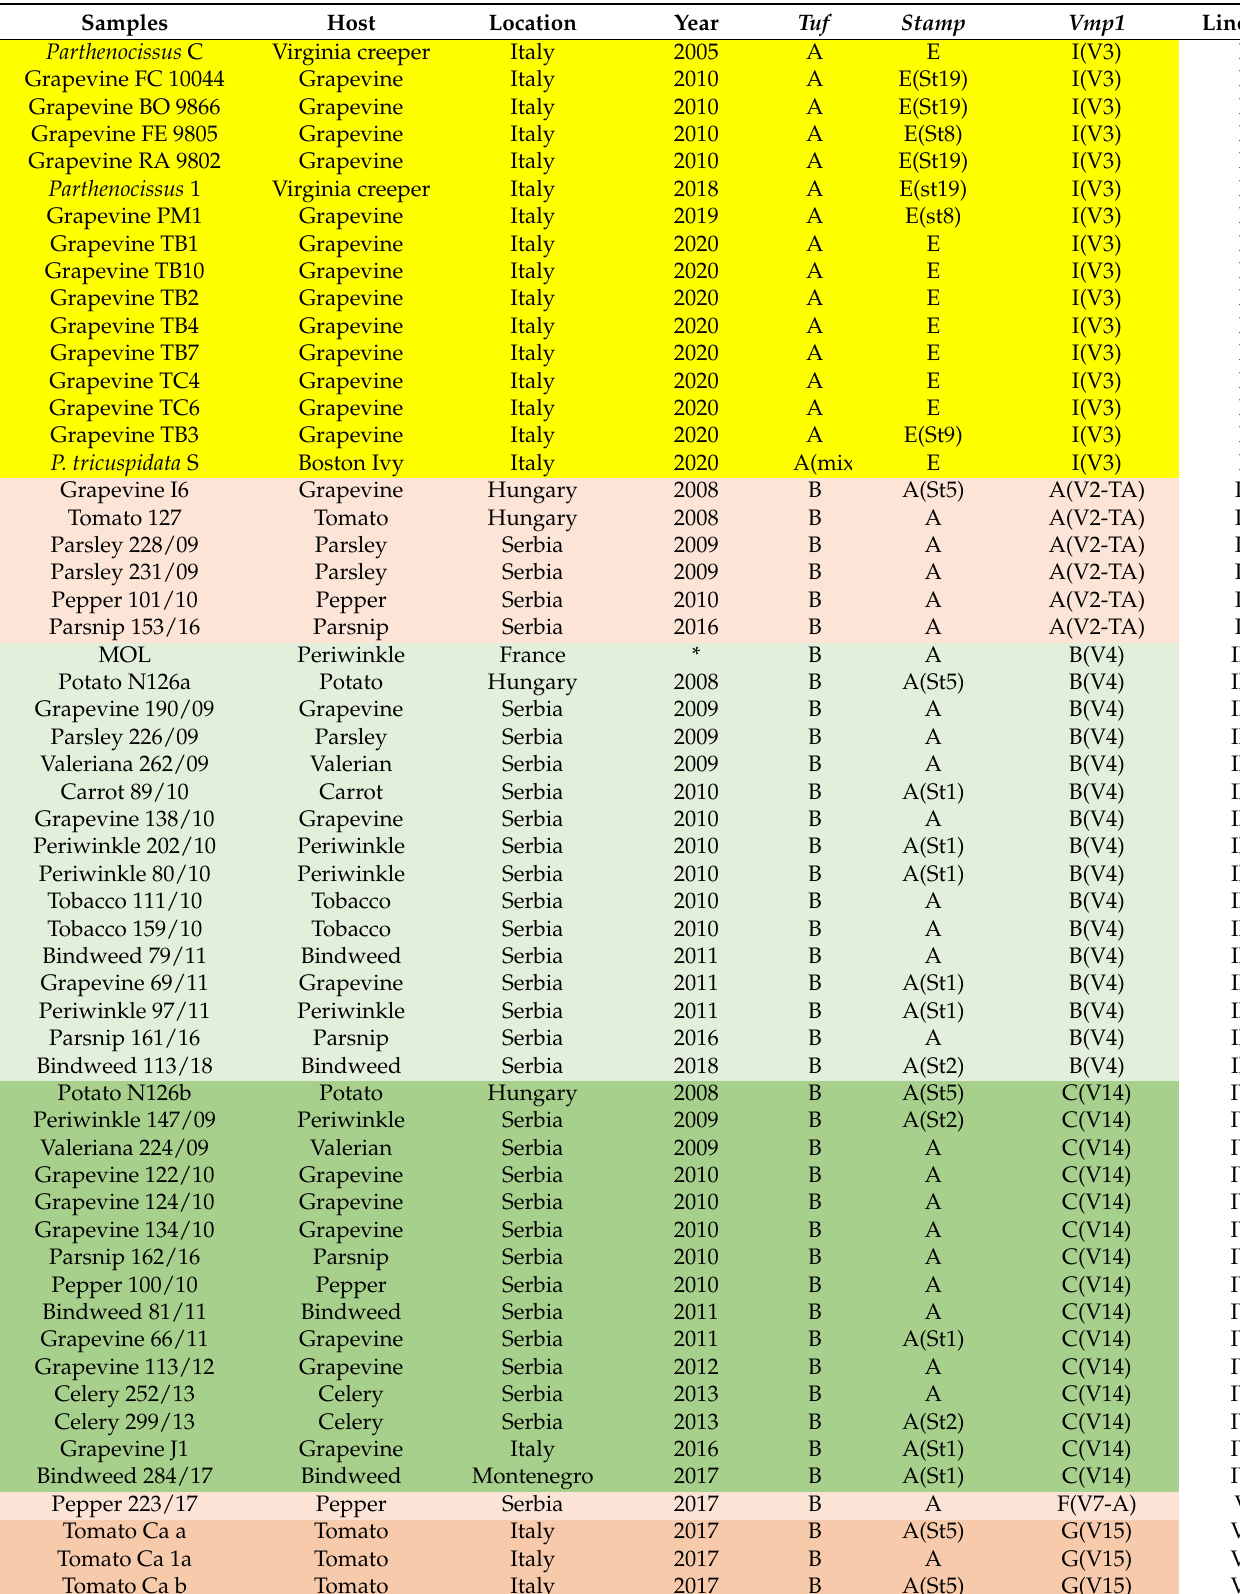
Table 2. RFLP profiles and lineages obtained on the genes of ‘Ca. P. solani’-infected samples analyzed. Identical background color means identical or possibly identical